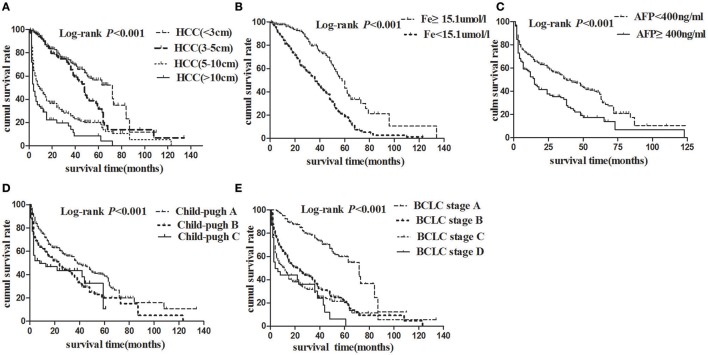
Cumulative survival plotted using the Kaplan-Meier survival curves and compared using log-rank test. (A) HCC patients with tumor size <3 cm (dashed line) had better overall survival than those with tumor size 3–5 cm (bold solid line), 5–10 cm (dotted line), or more than 10 cm (solid line) (P < 0.001). (B) HCC patients with higher serum iron levels (dashed line) had better overall survival than those with lower serum iron (solid line). (C) HCC patients with AFP < 400 ng/ml (dashed line) had better overall survival than those with AFP ≥ 400 ng/ml (dotted line). (D) HCC patients with Child-Pugh A (dashed line) had better overall survival than those with Child-Pugh B (dotted line), or C (solid line). (E) Patients with BCLC stage A (dashed line) had better overall survival than those with BCLC stage B (bold dashed line), C (dotted line), or D (solid line).